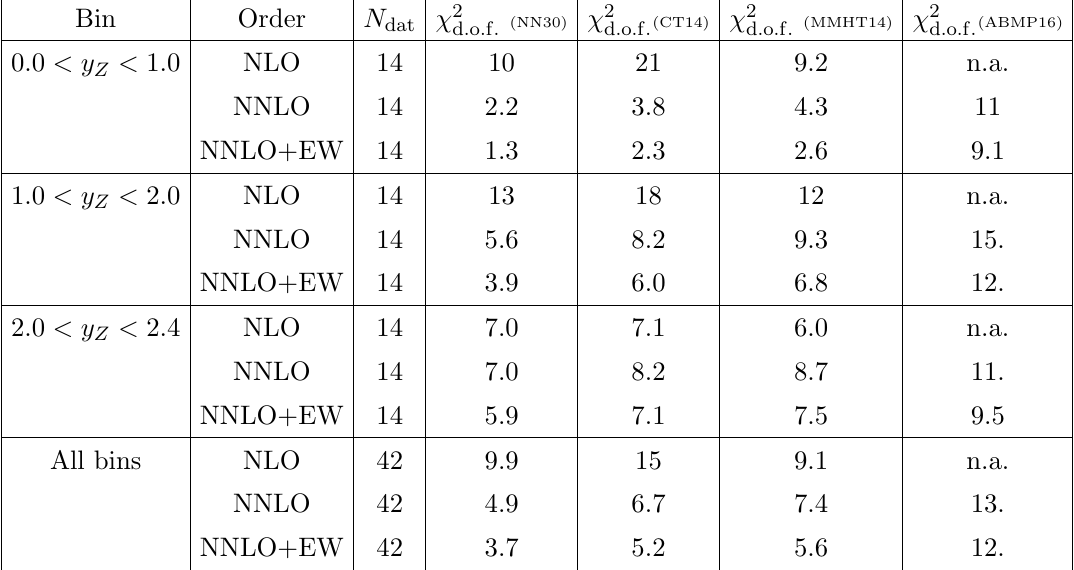
Table 1 . (cid:31) 2 per degree of freedom for the normalized ATLAS 7 TeV p Z the separate rapidity bins before their inclusion in the (cid:12)t. As input PDFs we use the NNPDF3.0 set with (cid:11) S ( M Z ) = 0118. The computation is done at NLO, NNLO and NNLO QCD + NLO EW, with (N)NLO PDF set for (N)NLO computations. Results for CT14, MMHT2014 and ABMP16 are also